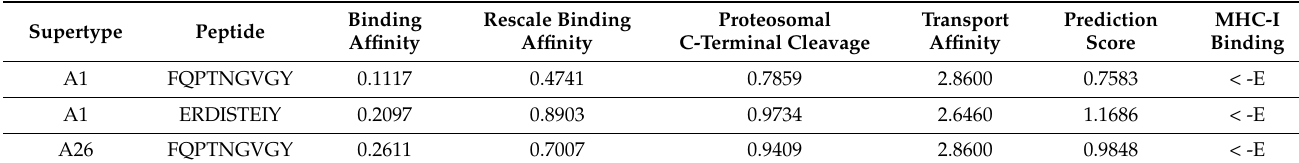
Table 6. Prediction of antigenic processing and presentation for potential T-cell epitopes of spike